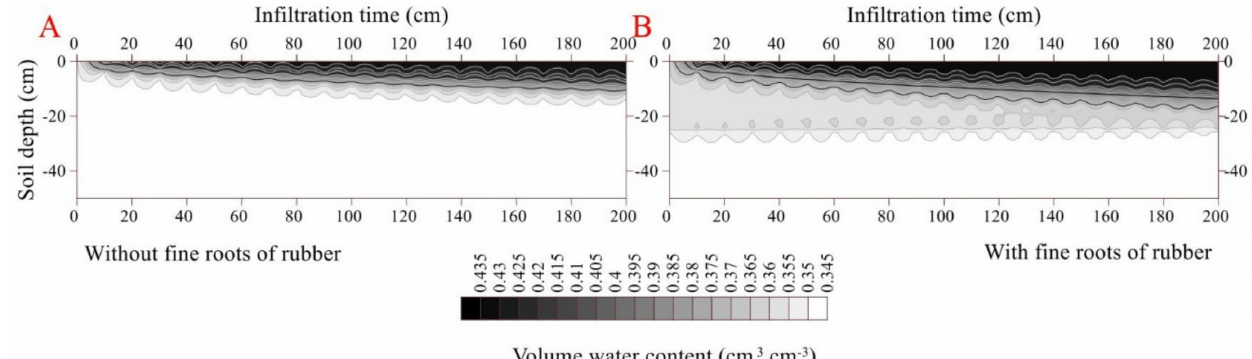
Figure 4. Effect of fine roots of rubber trees on infiltration ( A ). ( B , D ) shows the dynamic variation in volumetric water content and soil water pressure head in the soil profile without fibrous maize roots. ( C , E ) shows the dynamic variation in volumetric water content and soil water pressure head in the soil profile with fine rubber roots.